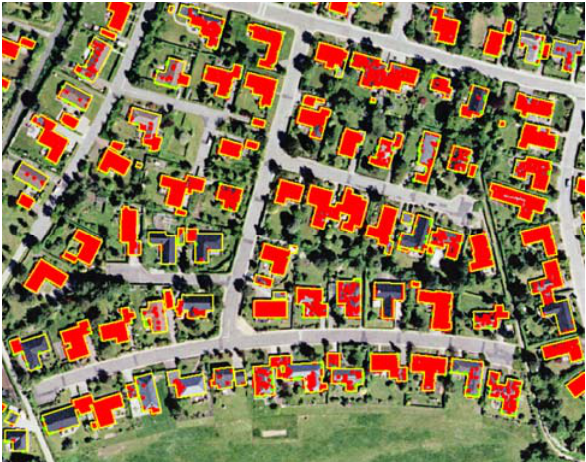
Figure 4. Orthoimage and vector map are used to select suitable roofs. Note that not all of the roofs contain footprints (red areas) The measuring of the image coordinates occurred on the